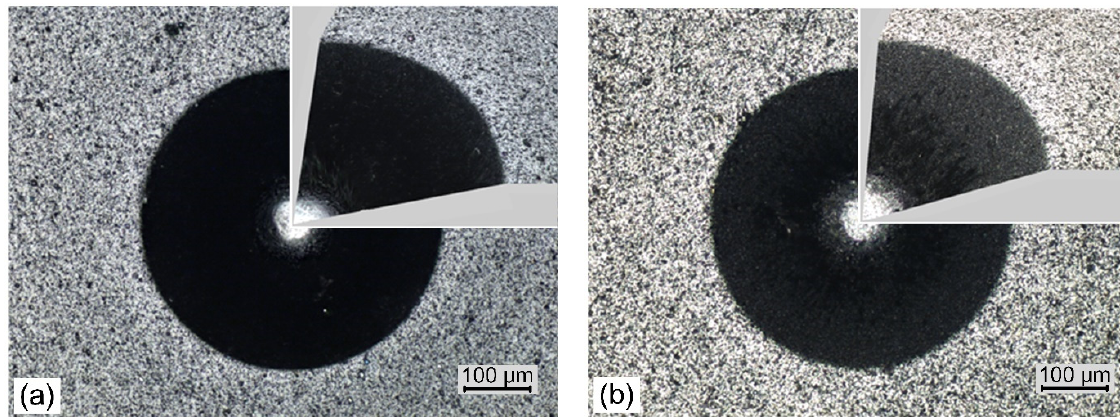
Figure 11. Daimler-Benz adhesion test results, SEM images of Rockwell indents for coatings formed at: ( a ) Ic = 50 A and ( b ) Ic = 100 A.